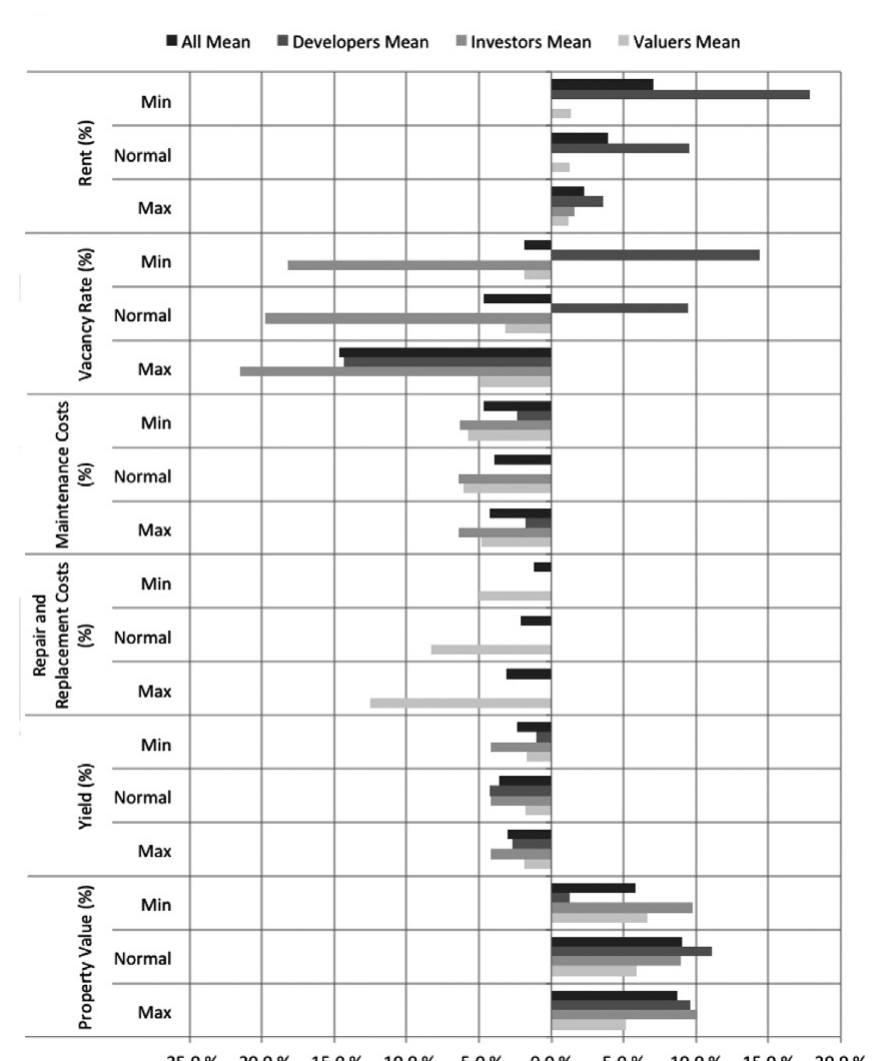
Fig. 3. Percentage changes in the DCF